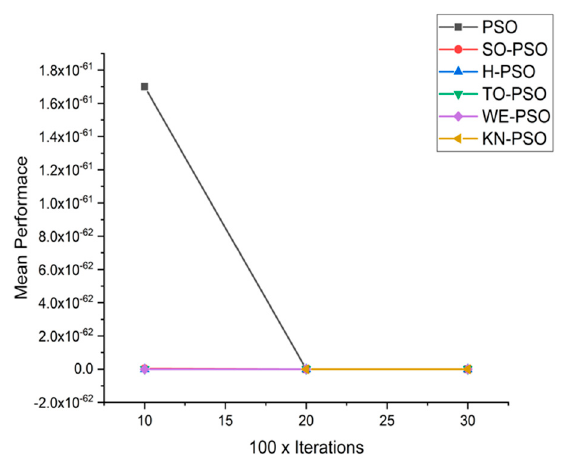
Figure 12. Convergence curve on fn6.